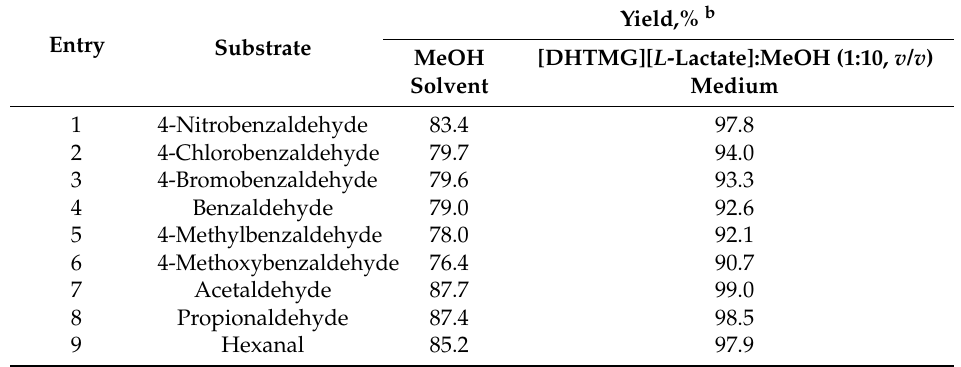
Table 5. Cyanosilylation of different aldehydes with TMSCN using catalyst 2 , in MeOH or in IL+MeOH mixture a